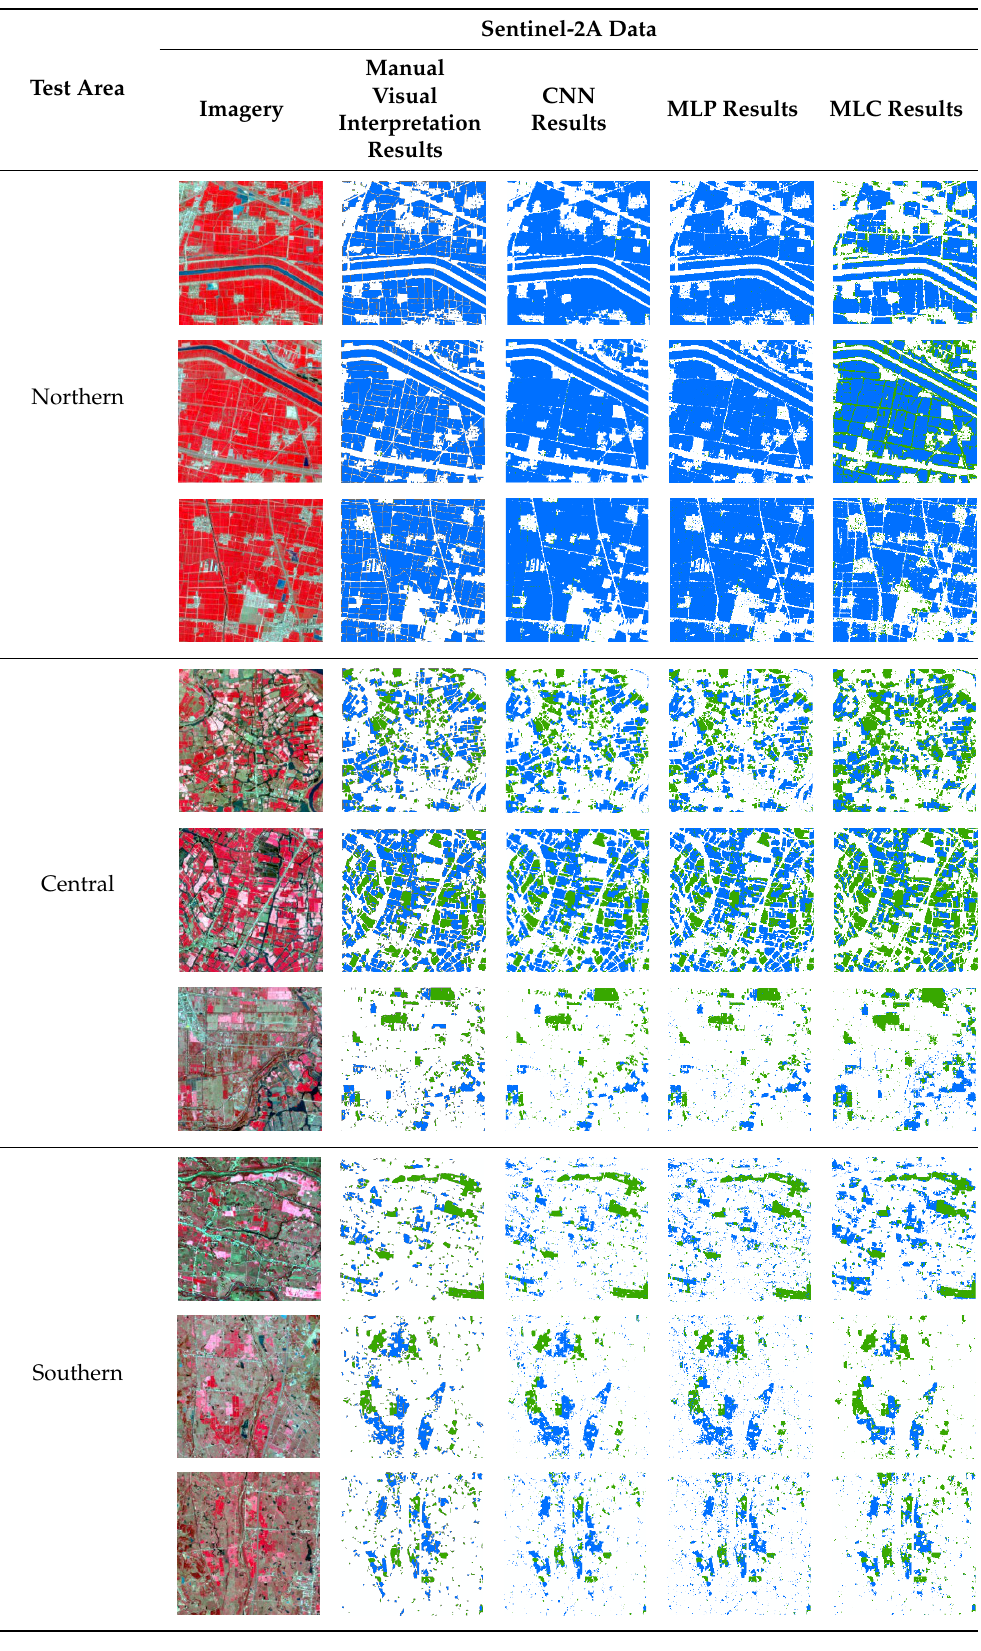
Table 14. Differences in the identification of winter wheat by different methods used on Sentinel-2A.